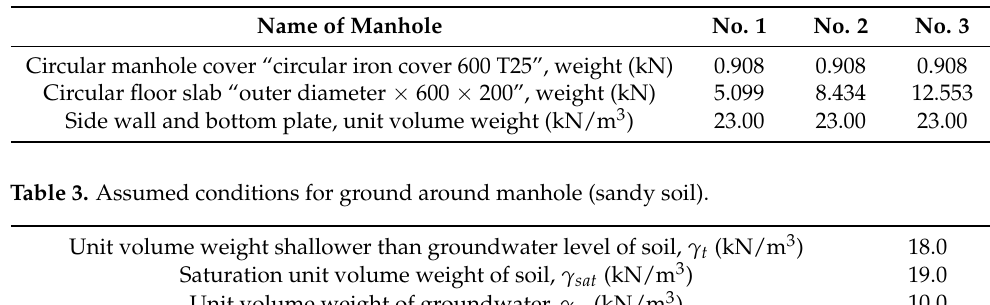
Figure 5. Specific dimensions of manholes Nos. 1, 2, and 3 in analysis. ( a ) No. 1 manhole ( b ) No. 2